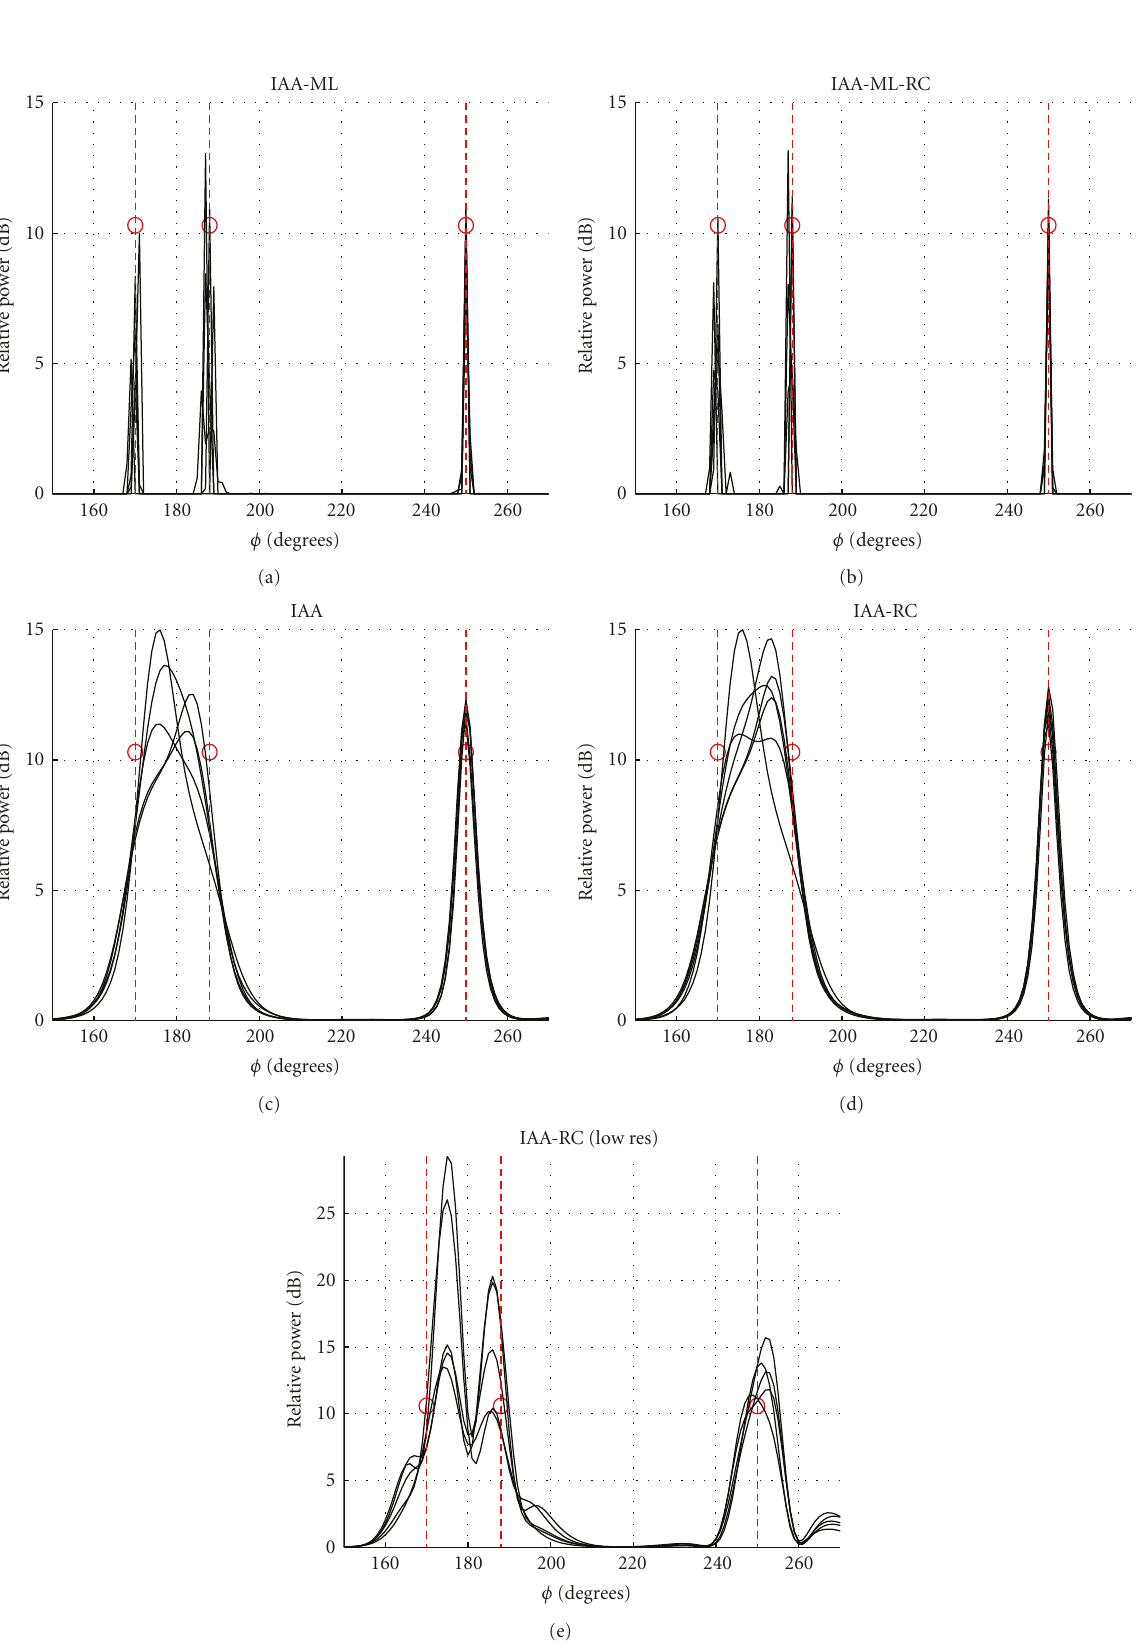
Figure 6: Spatial estimates of the di ff erent beamforming solutions (rectangular array, θ 1 = 45 ◦ , φ 1 = 170 ◦ , θ 2 = 45 ◦ , φ 2 = 188 ◦ , θ 3 = 45 ◦ , φ 3 = 250 ◦ , N = 10 snapshots, SNR 1 = SNR 2 = SNR 3 = 10 dB, noise power equal to 0dB, and f c =